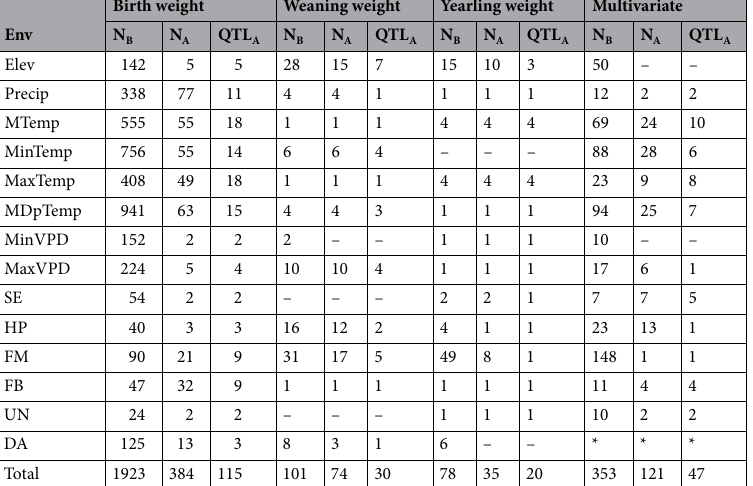
by population environmental substructure (in addition to population genetic substructure), which may cause spurious signals 13 , therefore for such analyses the P -values were adjusted using the genomic control inflation factor (Additional file 2, Table S2). After this adjustment, 614 G × E SNPs remained significant ( P < 1e−5, Table 1, Additional files 3 and 4), not all of which are independent. Figure 3 shows the absolute values of the significant G × E SNP effects and their allele frequency. The majority of the G × E SNP had small effects on the traits; however, large G × E SNP effects were also detected, such as the rs109164178 (chromosome 2: 81,187,988 bp) with effect of 6.6 kg on YW when interacting with minimum vapor pressure deficit (Fig. 3a); the rs110995777 (chromosome 13: 16,232,193 bp) with effect of 18.5 kg on YW when comparing animals reared in the Fescue Belt ecoregion and the total dataset (Fig. 3b), among others. The multivariate model also detected G × E SNP with large effects, such as rs42917868 (chromosome 14:52,925,690 bp) when interacting with mean dew point temperature has an effect of 0.07 kg, 2 kg, and 1.2 kg on BW, WW, and YW, respectively (Fig. 3c); and rs385339402 (chromosome 16: 49,283,484 bp) with G × E effect of 2.2 kg, 0.46 kg, and 9.1 kg on BW, WW, and YW, respectively, when comparing animals from the Southeast ecoregion and the total dataset (Fig. 3d). G × E SNPs were clustered into haplotype blocks based on their linkage disequilibrium, which are referred to as G × E QTL hereafter (Table 1). In total, 212 independent G × E QTL were detected. Few G × E QTL detected by the ecoregion G × E GWAA were also identified by the continuous G × E GWAA. These results indicate that the use of ecoregion information as environmental variable allowed us to capture G × E QTL interacting with region-specific stressors that were not directly measured (e.g. forage differences, water availability, pathogens) and the combination of multiple stressors. There was no overlap between the G × E QTL identified across the traits using univariate models, however, multivariate models detected several G × E QTL associated with BW, WW, or YW ( P < 1e−5, Table 1). In addition, multivariate analyses were able to detect G × E QTL that were not identifiable by standard univariate analyses, indicating advantages of incorporating a multivariate statistical approach to G × E genome-wide association studies of correlated traits. Consistent with our G × E variance component results, a larger number of G × E QTL was detected for BW than for WW or YW (Table 1). Temperature showed more interactions with QTL affecting BW than the other environmental variables analyzed ( P < 1e−5, Fig. 2a,b). The ecoregions that most interacted with QTL for BW were Fescue Belt and Forested Mountains ( P < 1e−5, Fig. 2g). For WW and YW, elevation (Fig. 2c) was found to be the continuous environmental variable that most interacted with genotype ( P < 1e−5, Fig. 2d,e respectively). In agreement, Forested Mountains, the ecoregion with the highest elevation (Additional file 2: Table S1), showed more genotype-by-environment interaction for WW and YW (P < 1e−5, Fig. 2h,i , respectively), compared with other ecoregions. No common G × E QTL was identified for two or more different ecoregions indicating that the